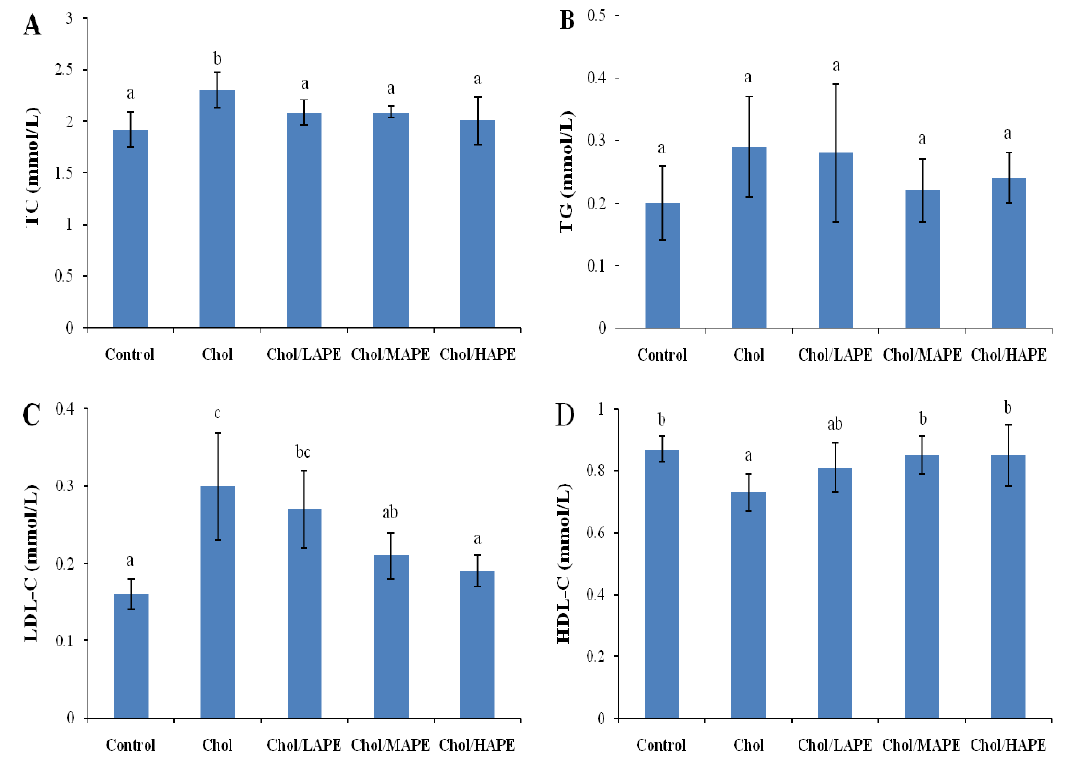
Figure 1. Effect of APE on serum TC ( A ), TG ( B ), LDL-C ( C ) and HDL-C ( D ) levels in rats. Values are expressed as mean ± SD. Bars not sharing common letter superscripts are significantly different ( p <